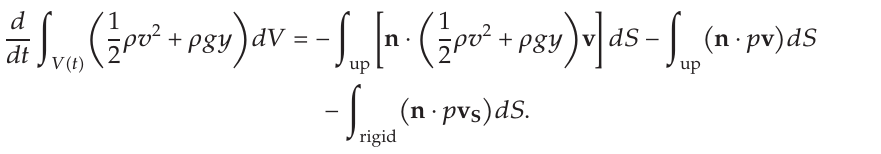
For the computation domain, up edge is open and outlet boundary, solid edges of wedge are moving wall boundary, and left, down, and right edges are fixed wall